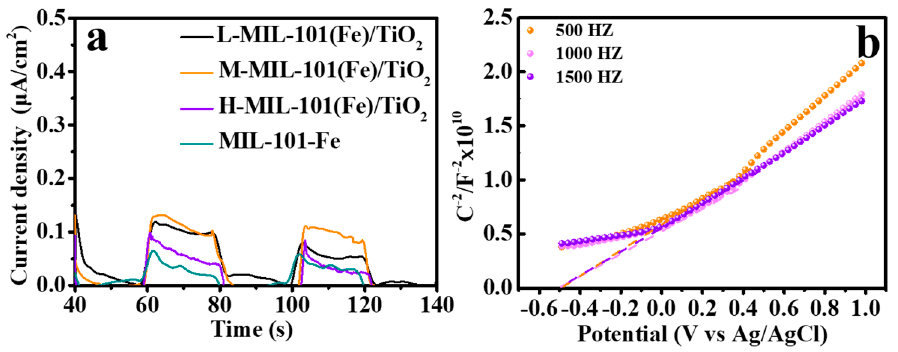
Figure 8. ( a ) Photocurrent of MIL ‐ 101(Fe) and MIL ‐ 101(Fe)/TiO 2 catalysts under UV irradiation; ( b ) Typical Mott–Schottky plots of MIL ‐ 101(Fe).